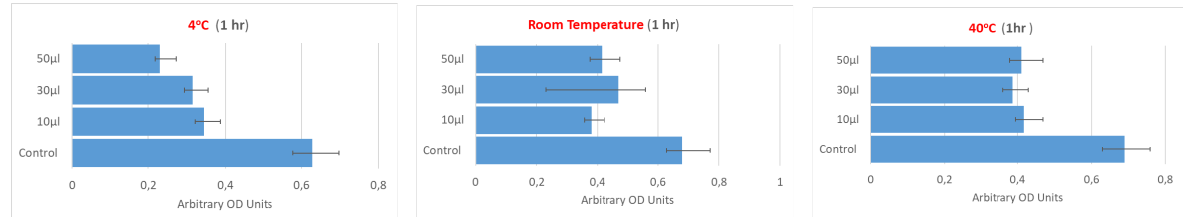
Figure 3. Effect of temperature (4 ◦ C, 25 ◦ C RT, 40 ◦ C), magnetic nanoparticles concentration (10 µ L, 30 µ L, 50 µ L), and elution time (60 min) on the recovering of commercial astaxanthin . Histograms represent solutions absorbance, for each sample a spectrophotometer measure was performed at 530 nm. Units are presented as OD (Optical Density).